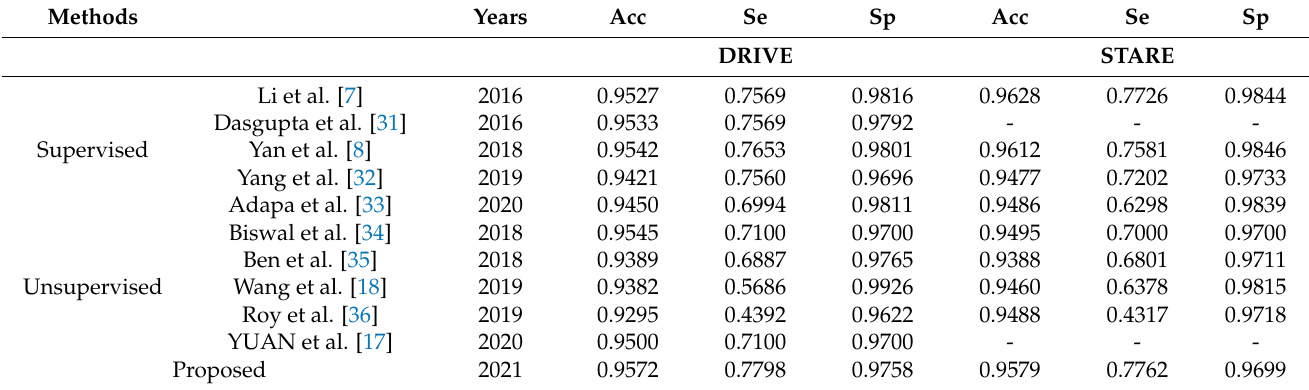
Table 5. Comparison of proposed method and other methods on DRIVE and STARE